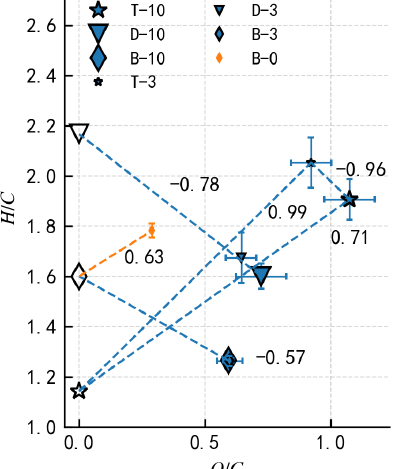
Figure 7. The elemental H / C ratio as a function of the O / C ratio for three pure organic precursors (hollow symbols) and corresponding COJ300 BC particles seeding SOA inside the PAM reactor (filled symbols). Different symbol sizes denote different OH exposure lev- els. The negative slopes of SOA coating experiments are consistent with the simultaneous carboxylic acid group addition and C–C sin- gle bond breakage (Heald et al., 2010; Lambe et al., 2011b).